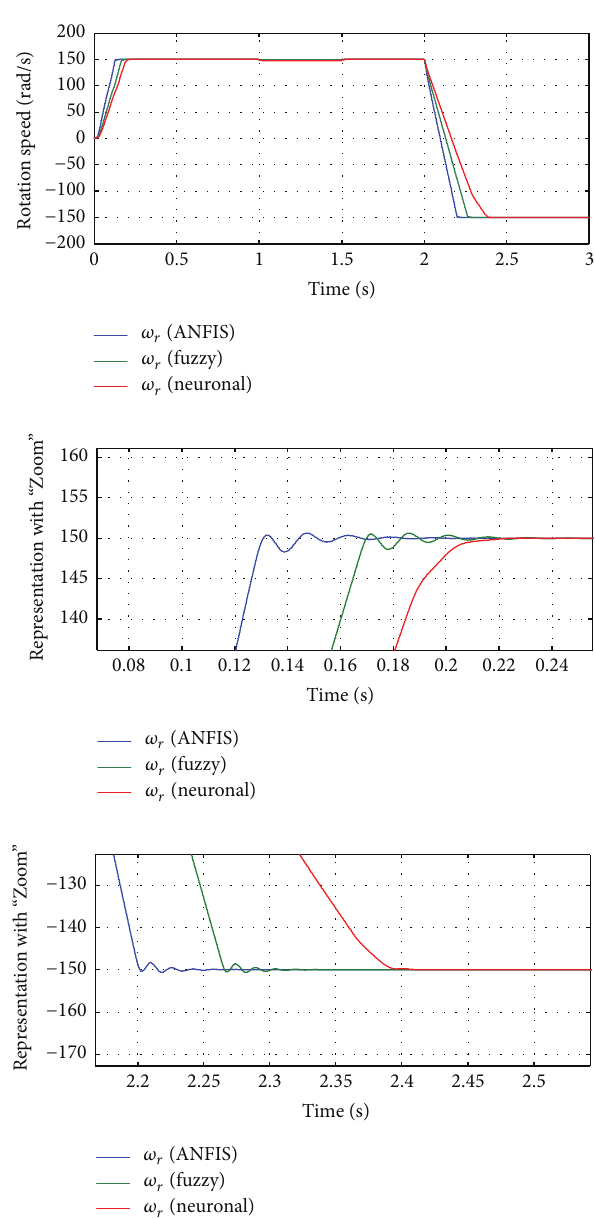
Figure8:Speedwiththethreetechniquescontrol:fuzzy,neural,and